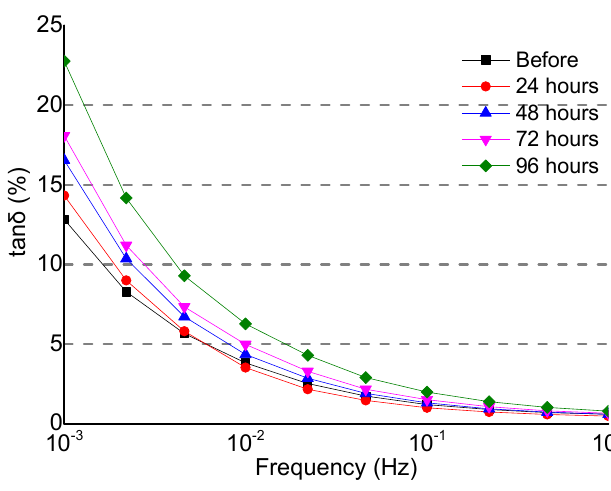
Figure 8. Change of tanδ from 0.001 to 1 Hz.